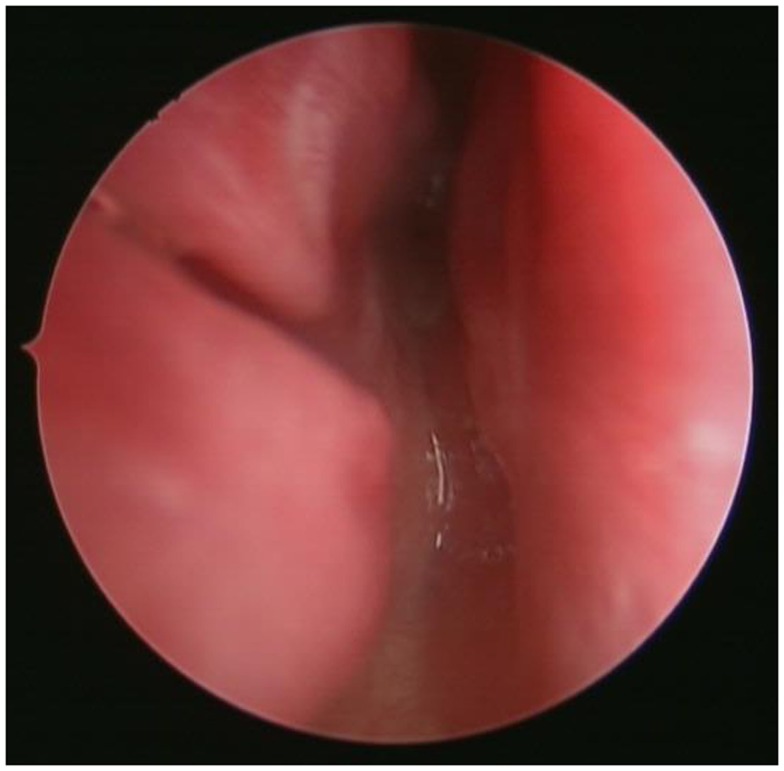
Endoscopic view of the atretic plate of the choanal atresia.